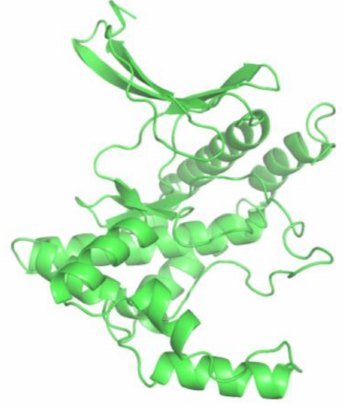
Figure 3. Constructed 3D model of ATR